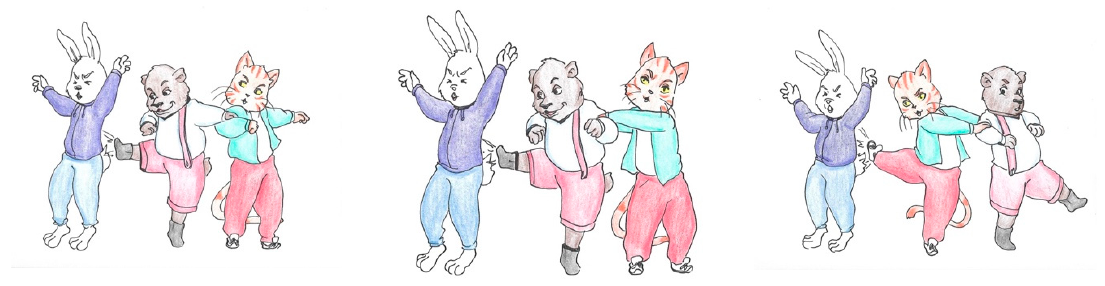
Figure A9. SRC stimulus 4.